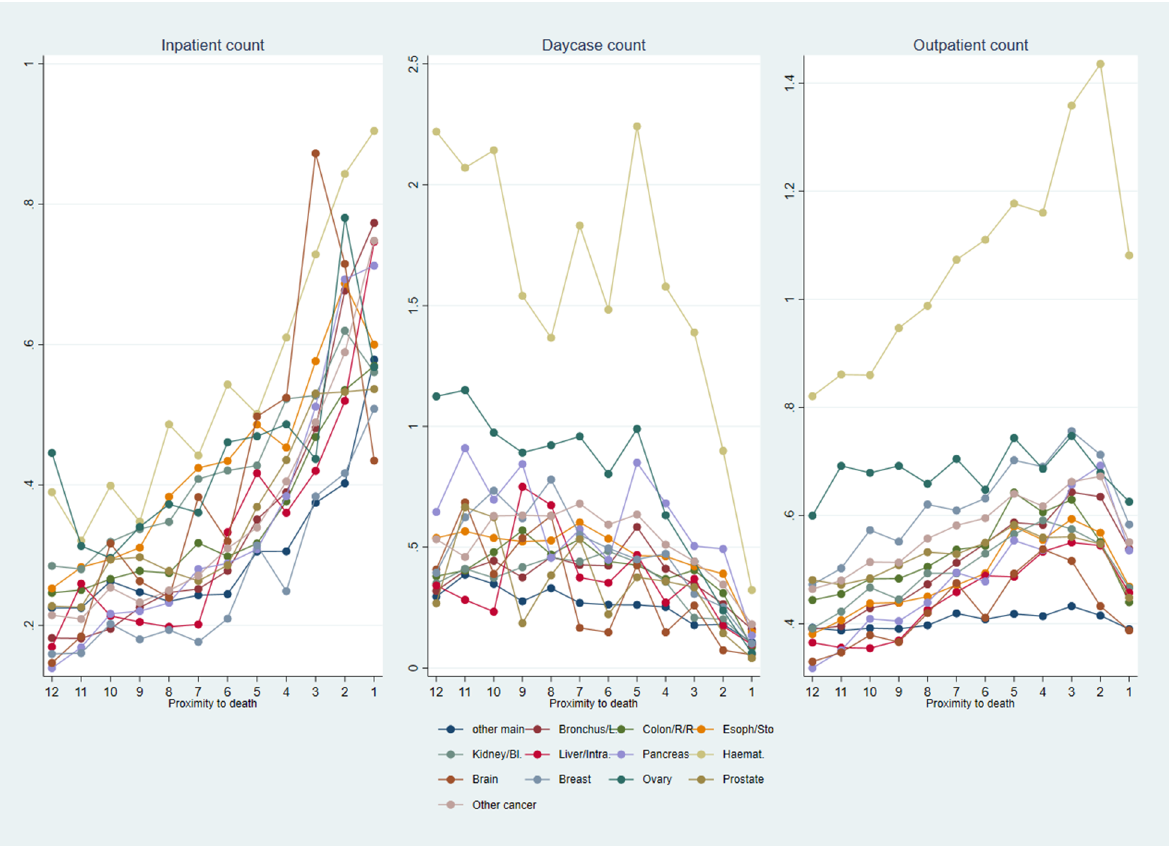
Figure 1: Inpatient, day case and outpatient resource use patterns, in cancer- patients’ last 12 months of life. Proximity to death (in month) on the x-axis; average resource use within each month (counts) on the y-axis. Results are presented for each cancer